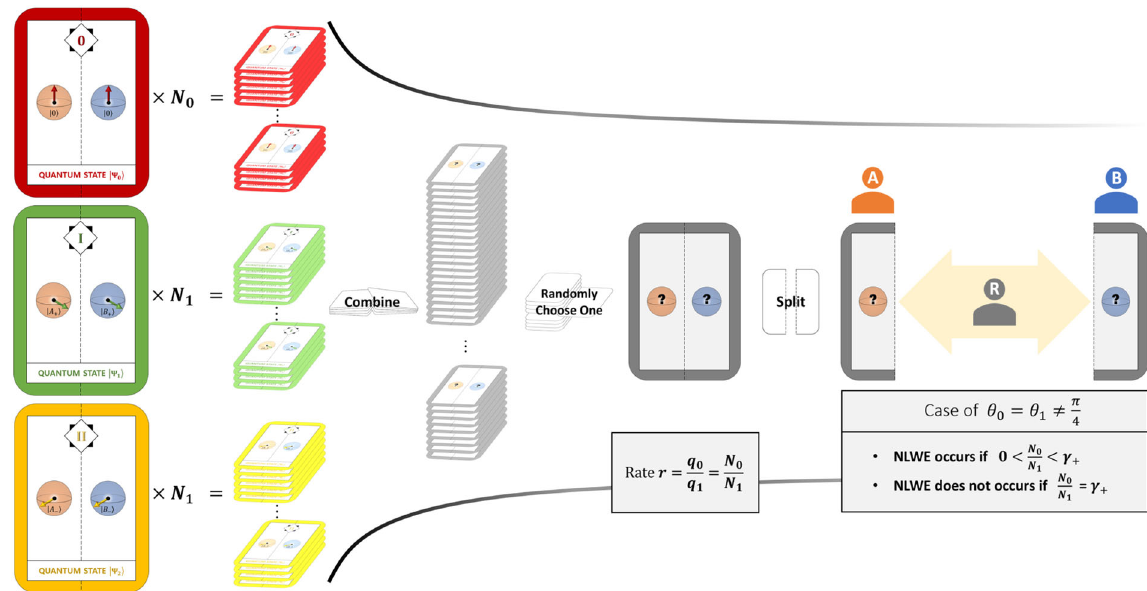
Fig. 2 NLWE in the case of θ 1 ¼ θ 0 ≠ π . In two-qubit system, a party R prepares N 0 number of quantum state Ψ 0 j i (red), N 1 number of 4 quantum state Ψ 1 j i (green), and N 1 number of quantum state Ψ 2 j i (yellow). R combines N 0 + 2 N 1 quantum systems and randomly chooses one out of them. Then, the prior probability q 1 of quantum state Ψ 1 j i is equal to the prior probability q 2 of quantum state Ψ 2 j i . The ratio r between the prior probability q 0 of quantum state Ψ 0 j i and the prior probability q 1 is N 0 / N 1 . After the preparation, R sends each qubit to A and B , respectively. When 0 < r < γ + is satis fi ed, NLWE occurs in the view of MD, but if r = γ + , NLWE does not occur. More explicitly, because θ fi es sin θ = 5 , if N = 600, NLWE does not occur when N γ + becomes 343/600 when 0 ¼ 3 0 satis 1 0 is 343. However, NLWE occurs in the case of N 0 = 1, 2, … ,